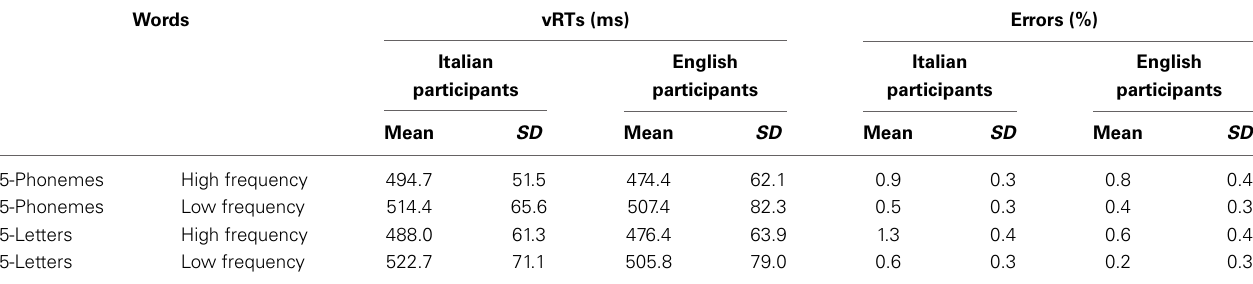
Table 4 | Means (and standard deviations) of vRTs and error rates (% of errors) of Italian and English participants for all experimental conditions of Experiment 3.